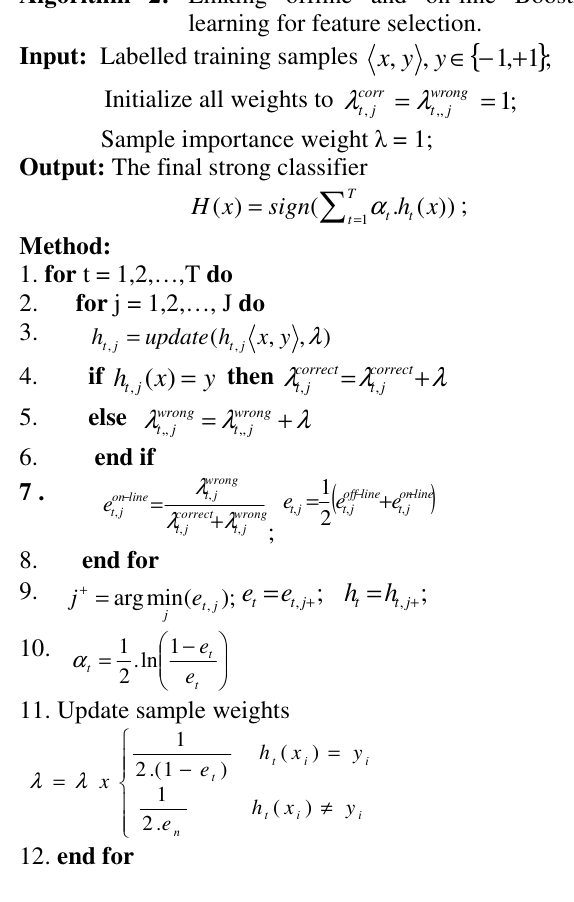
Algorithm 2: Linking offline and on-line Boosting learning for feature selection.